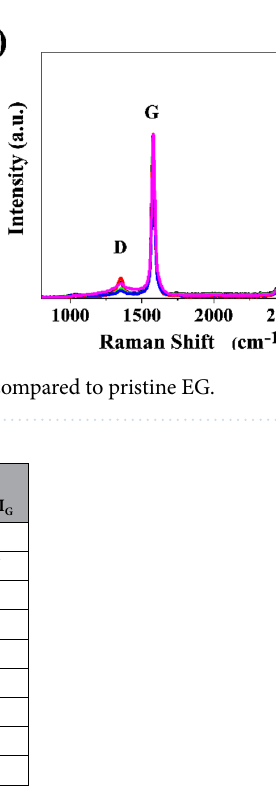
Table 2. Raman band positions and intensities, as well as the intensity ratio of EG and graphene obtained in 1A-T and 1B-T series.